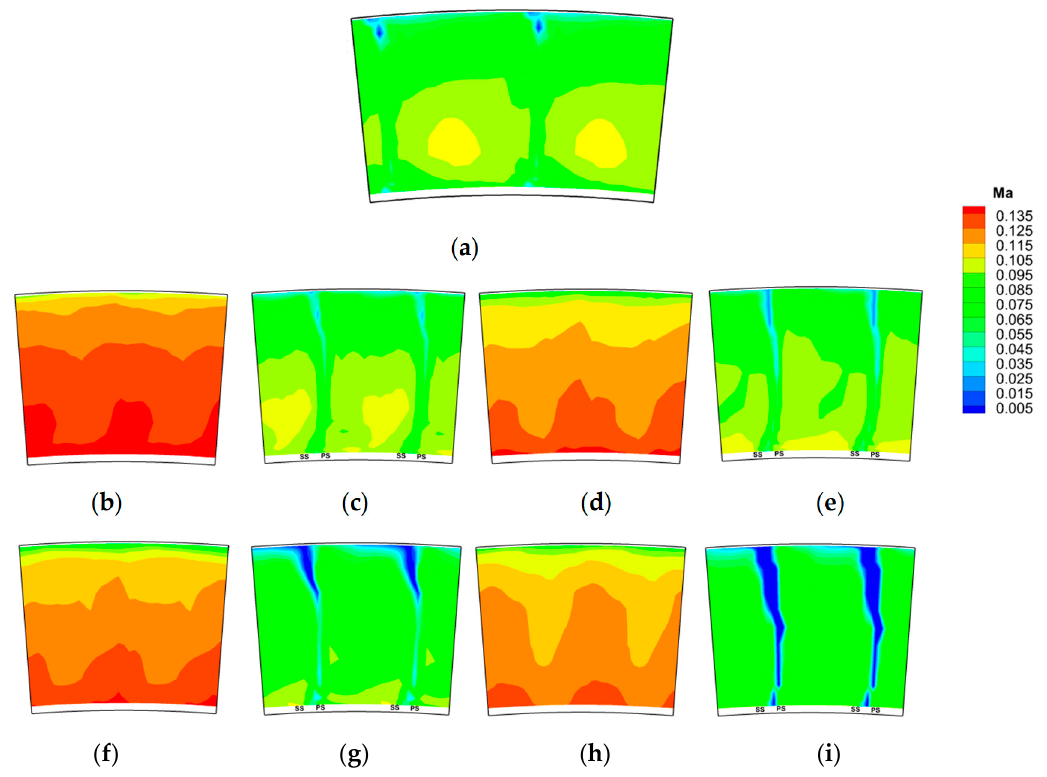
Figure 5. Absolute Mach number contours at the design point. ( a ) Inlet of R1; ( b ) Outlet of R1; ( c ) Outlet of S1; ( d ) Outlet of R2; ( e ) Outlet of S2; ( f ) Outlet of R3; ( g ) Outlet of S3; ( h ) Outlet of R4; ( i ) Outlet of S4.